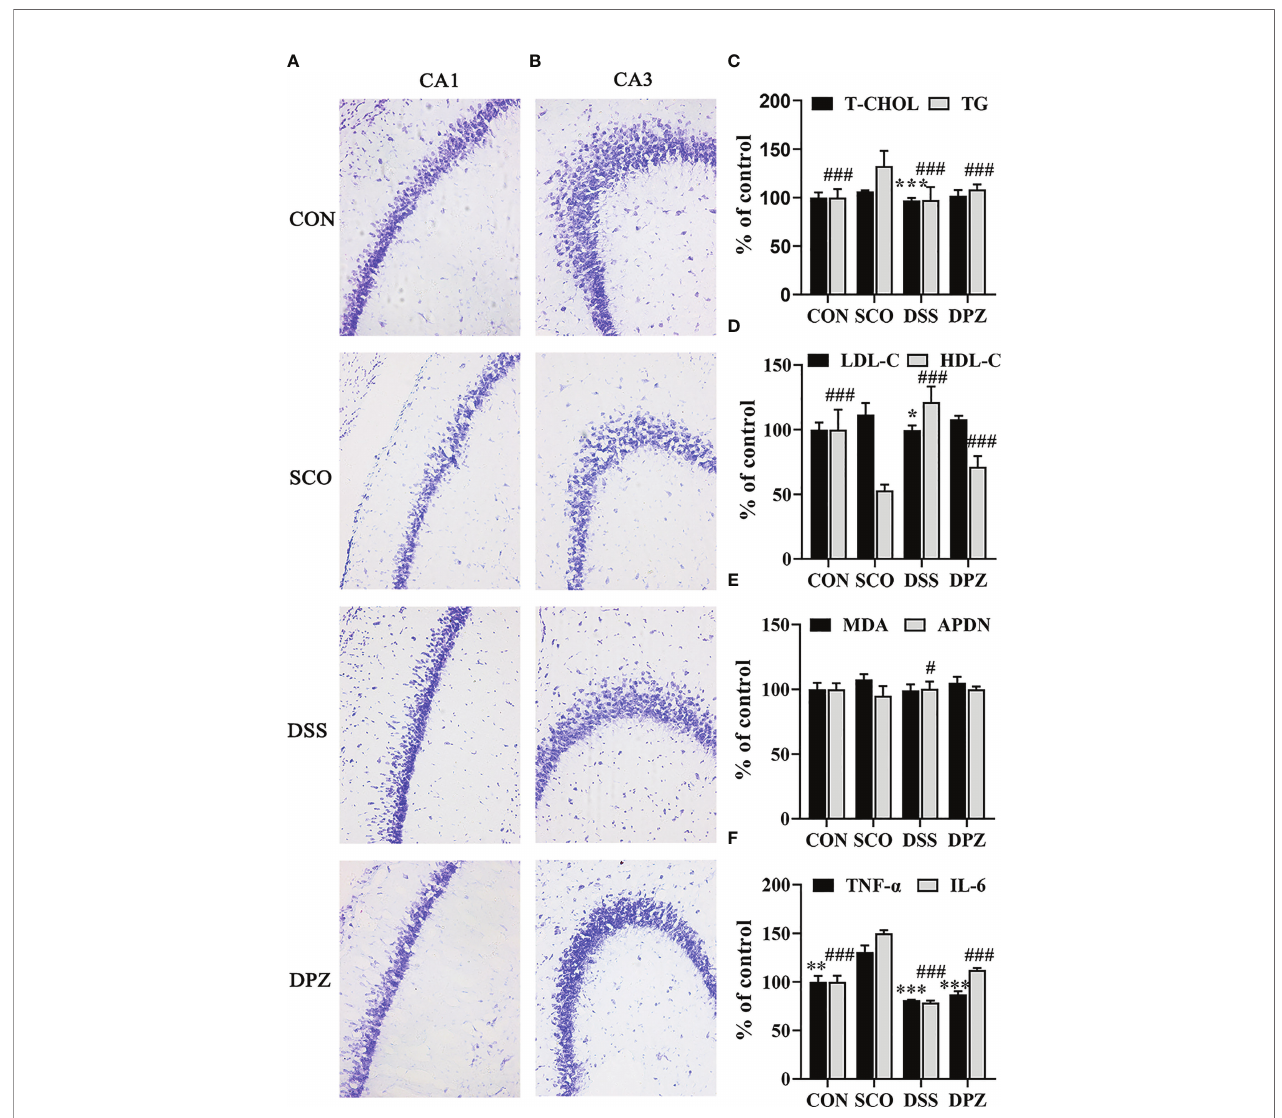
FIGURE 5 | DSS restored dementia-related morphological anomalies in the hippocampus. Evaluation of the number of surviving neuronal cells in mice by Nissl ’ s staining. (A) Representative microphotographs of the Nissl ’ s stained CA1 area of hippocampal sections from the 4 experimental groups at ×20 magni fi cation. Nissl bodies were dyed deep blue, and the cell nuclei were lightly stained. (B) Representative microphotographs of the Nissl-stained CA3 area of hippocampal sections from the 4 experimental groups at ×20 magni fi cation, bar = 100 m m. The image represents 1 mouse. The studies were repeated twice in another 2 mice. (C – F) In fl ammation cytokines and lipid levels in the brain (n=3-5). (C) Total cholesterol (T-CHO) expression in the brain of the mice *** p < 0.001 vs. SCO; total glyceride (TG) expression in the brain of the mice ### p < 0.001 vs. SCO. (D) Low-density lipoprotein cholesterol (LDL-C) expression in the brain of the mice * p < 0.05 vs. SCO; high-density lipoprotein cholesterol (HDL-C) expression in the brain of the mice ### p < 0.001 vs. SCO. (E) Malondialdehyde (MDA) and adiponectin (APDN) # p < 0.05 vs. SCO expression in the brain of the mice. (F) TNF- a expression in the brain of the mice ** p < 0.01, *** p < 0.001 vs. SCO; IL-6 expression in the brain of the mice ### p < 0.001 vs.